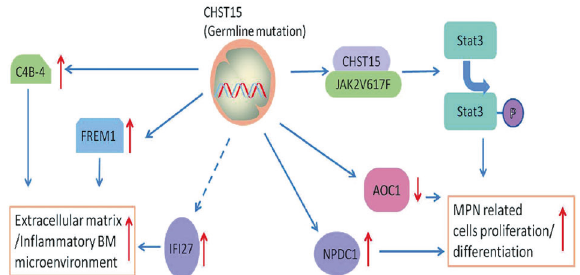
Fig. 7 A diagram of gene regulatory network for describing the possible mechanism in familial MPN with germline CHST15 mutation resulting in the dysregulation of MPN cells proliferation, differentiation and BM microenvironment unbalance. Upward arrows: upregulated; Down arrow: